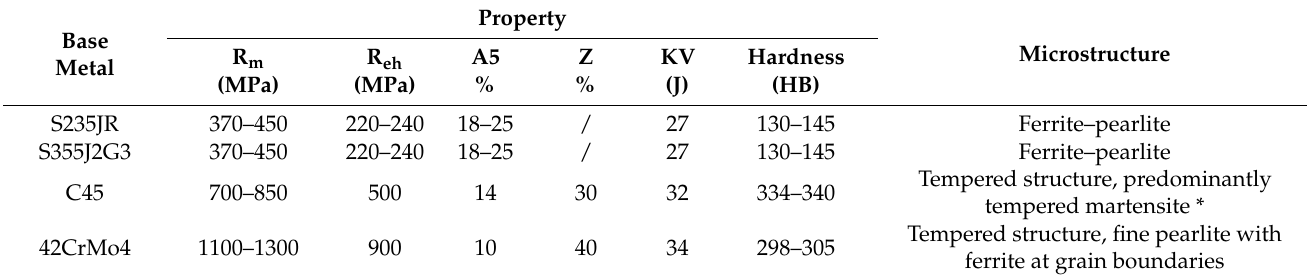
Table 3. Mechanical properties and microstructure of the tested steels